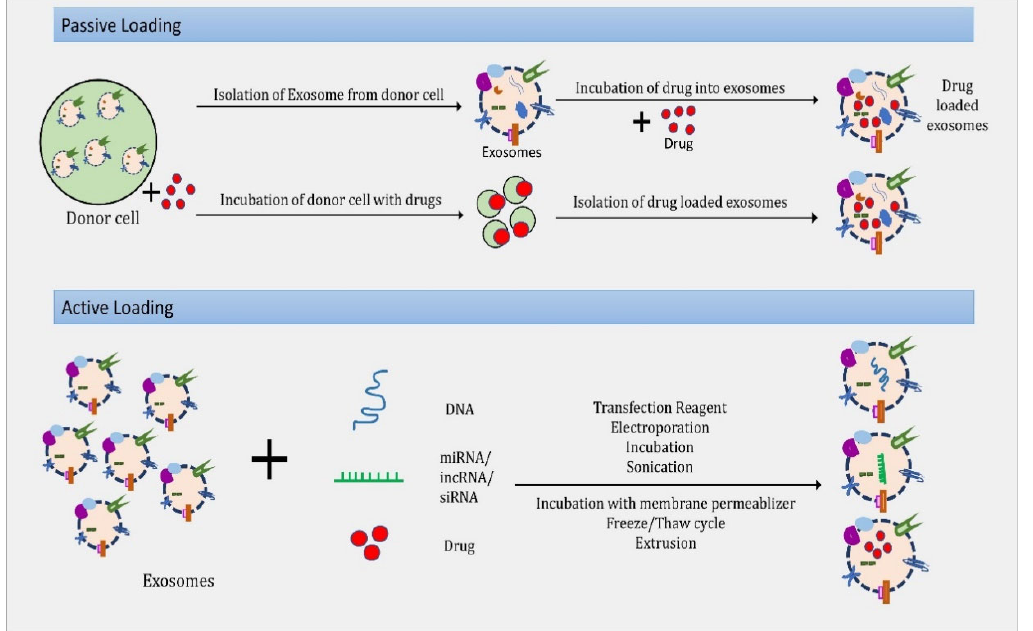
Figure 3. Passive and active loading methods of exosomes.